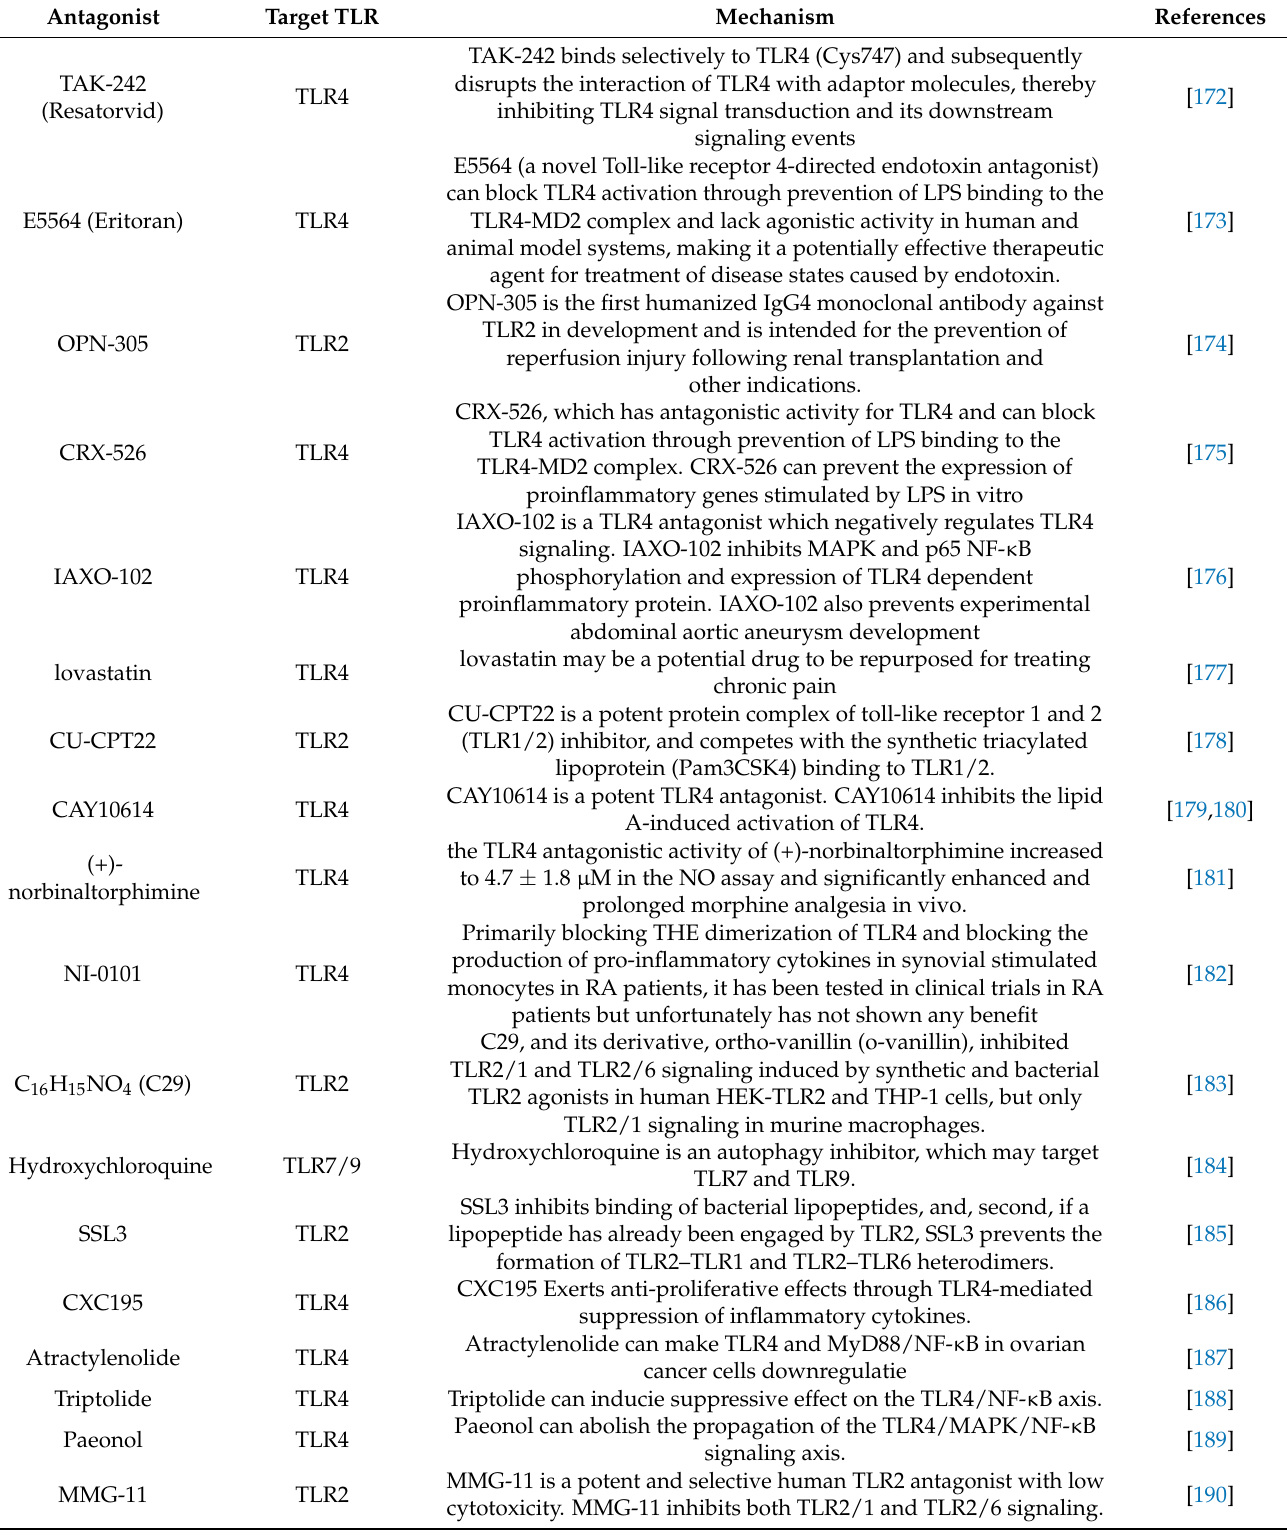
Table 3. Some experimental types of TLR